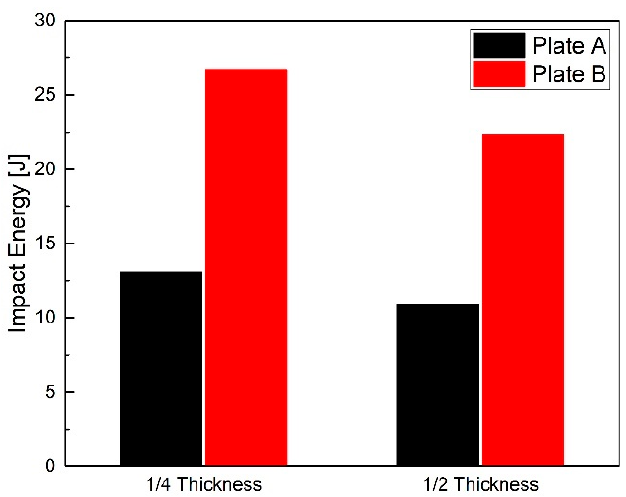
Figure 13. Impact energy of Plate A and Plate B.